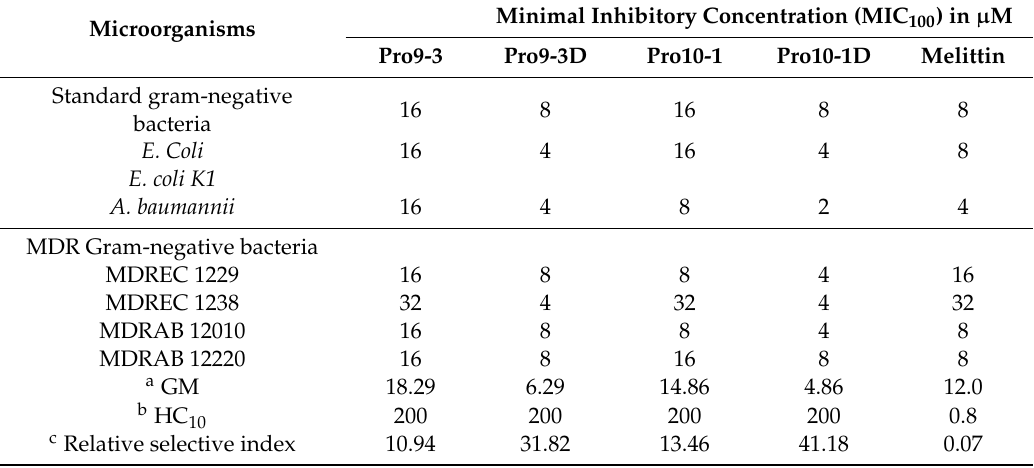
Table 2. Activities of Pro9-3 and its analogs against microorganisms.